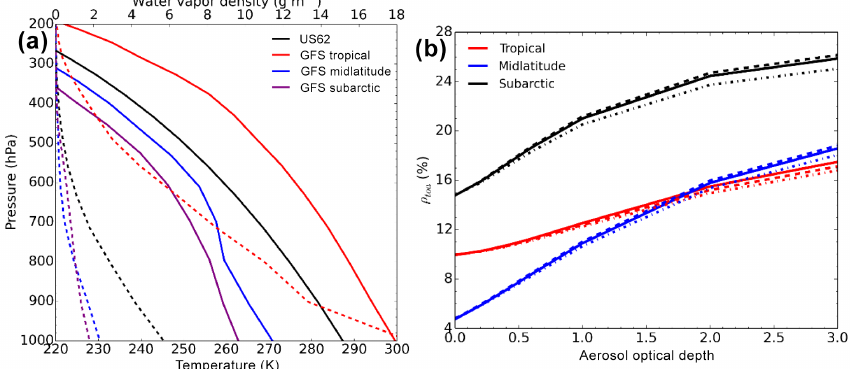
Figure 7. (a) Temperature (solid) and water vapor density (dashed) from the US standard profile and GFS profiles extracted from tropical, midlatitude, and subarctic regions. (b) 6SV model output of ρ toa for AOD ranging from 0 to 3 for US standard (solid) and GFS atmospheric profiles from January (dashed) and July (dotted/dashed) 2014 in different regions. Specified θ 0 , θ , and R sfc in Table 5 were additional inputs into the model.